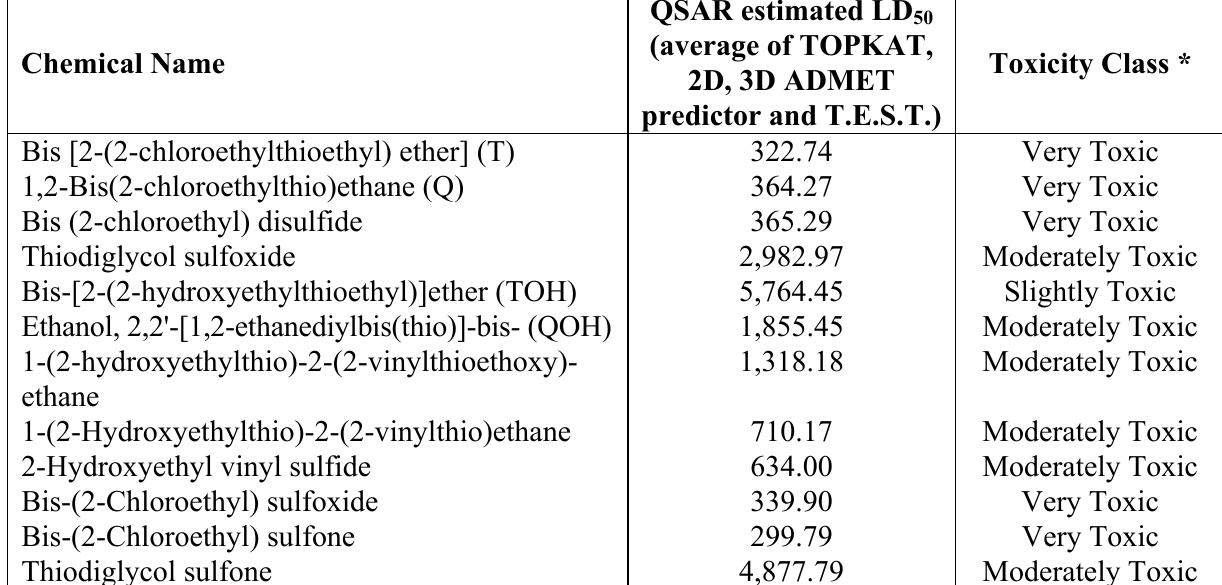
values and the classification of HD breakdown products 50 50